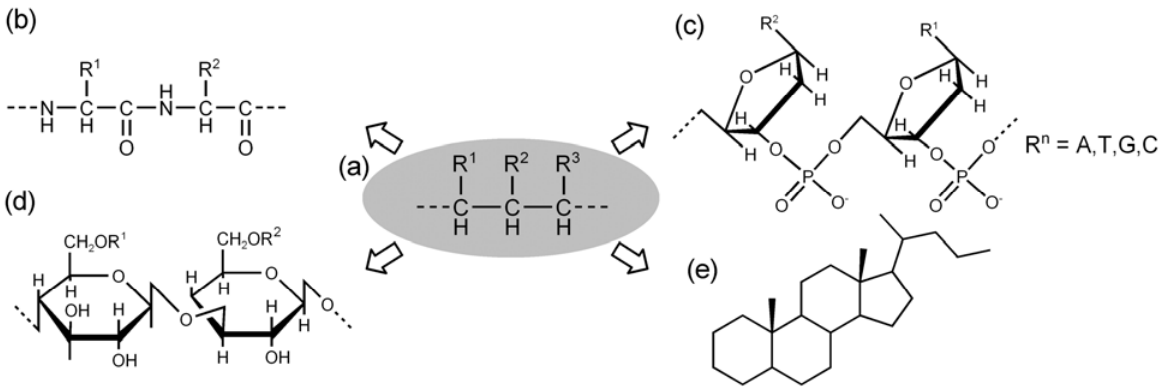
Figure 7. A polymethylene chain with various substituents (a) serves as storage of molecular information. The sequential carbon chain can be theoretically modified to a polypeptide chain (b), a polynucleotide chain (c), a polysaccharide chain (d), and a polycyclic chain